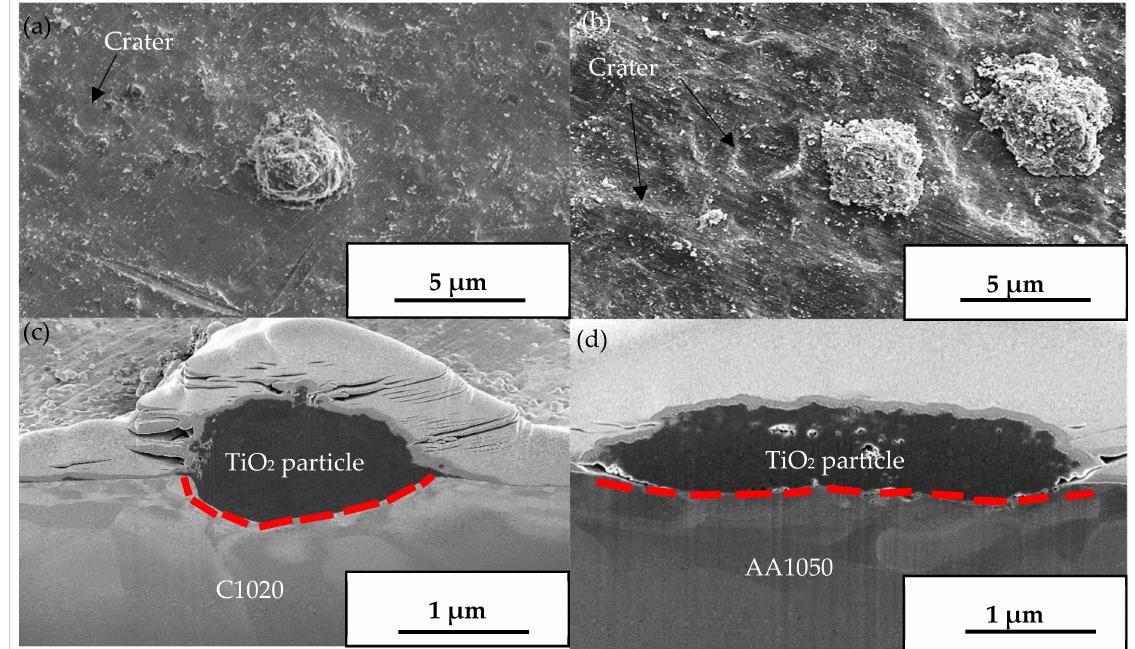
Figure 11. SEM images of the TiO 2 particle on ( a ) C1020 annealed at 400 ◦ C, ( b ) AA1050 and cross-sectional images of titanium dioxide particle on ( c ) C1020 and ( d ) AA1050 heat-treated at 400 ◦